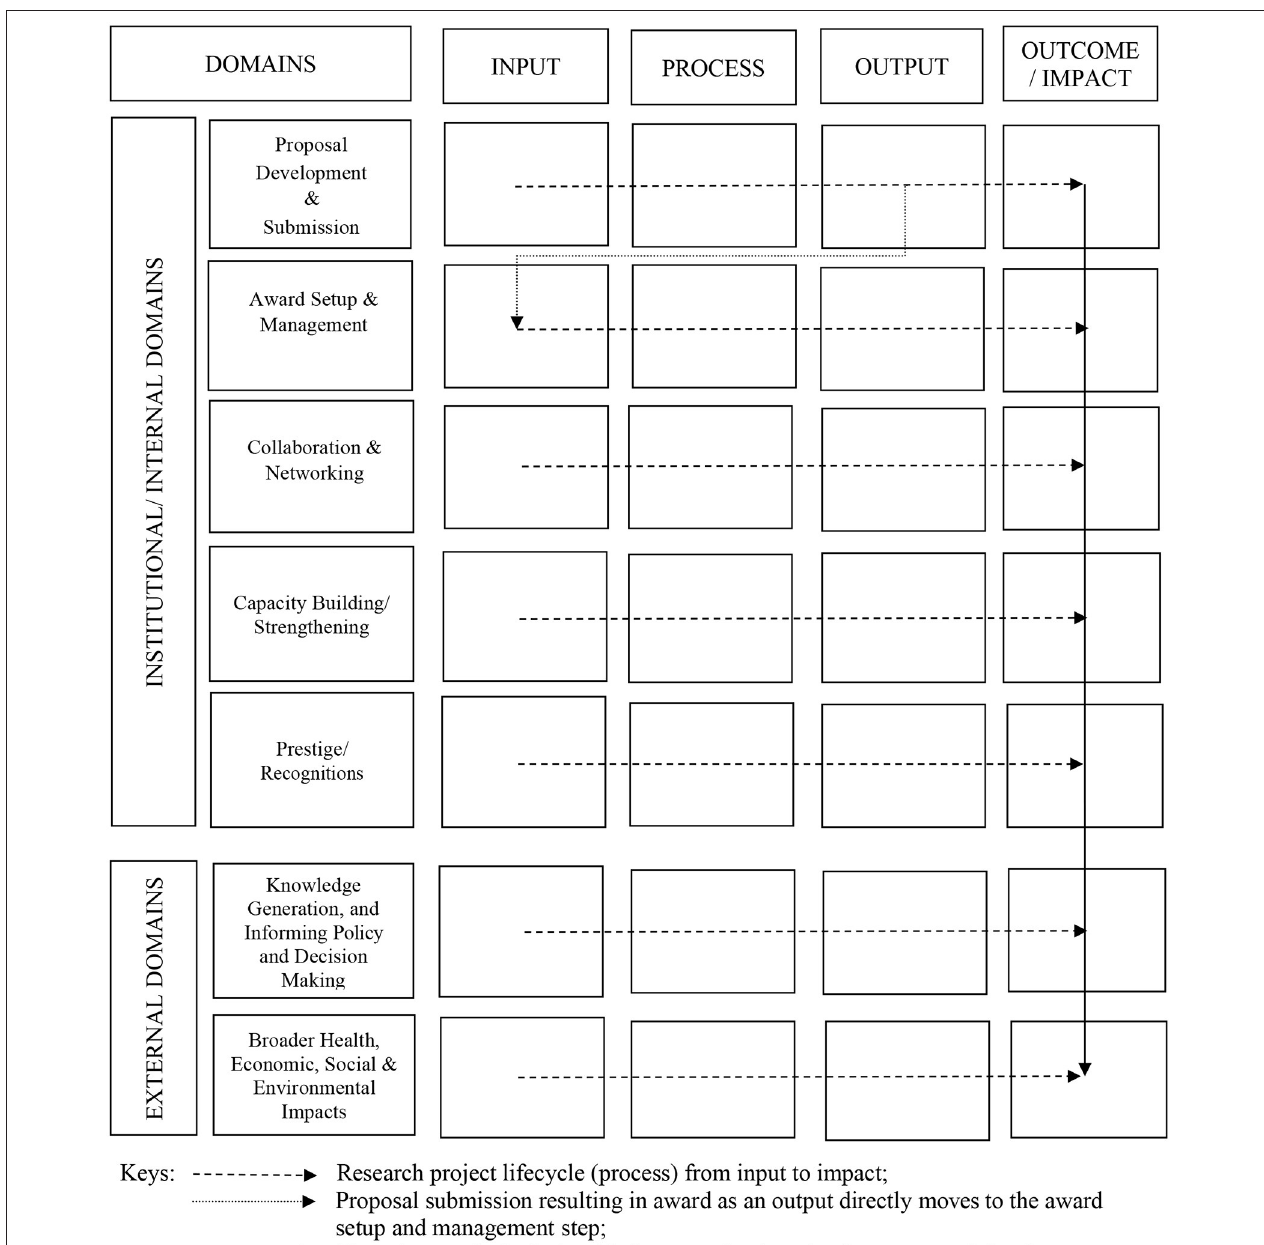
FIGURE 1 | Proposed research metrics conceptual